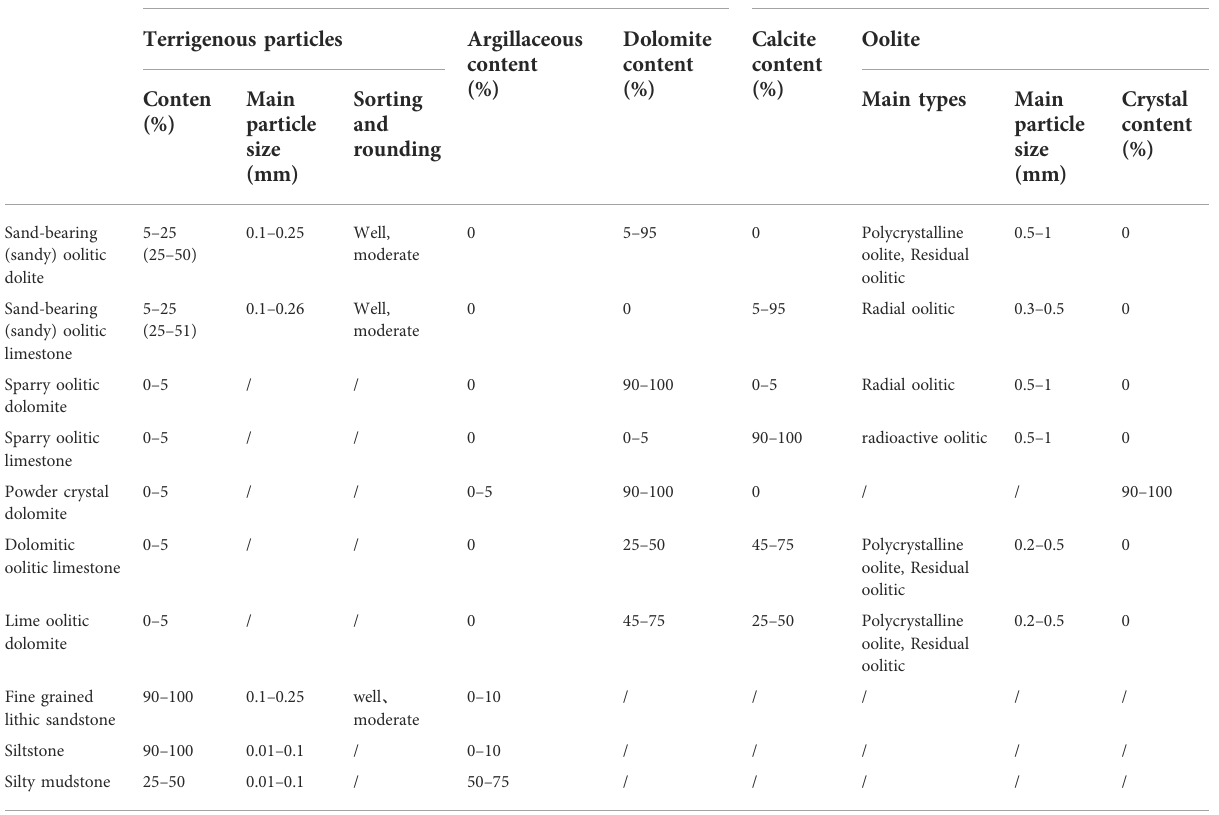
TABLE 1 Rock characteristic of the fi rst member of Canglangpu